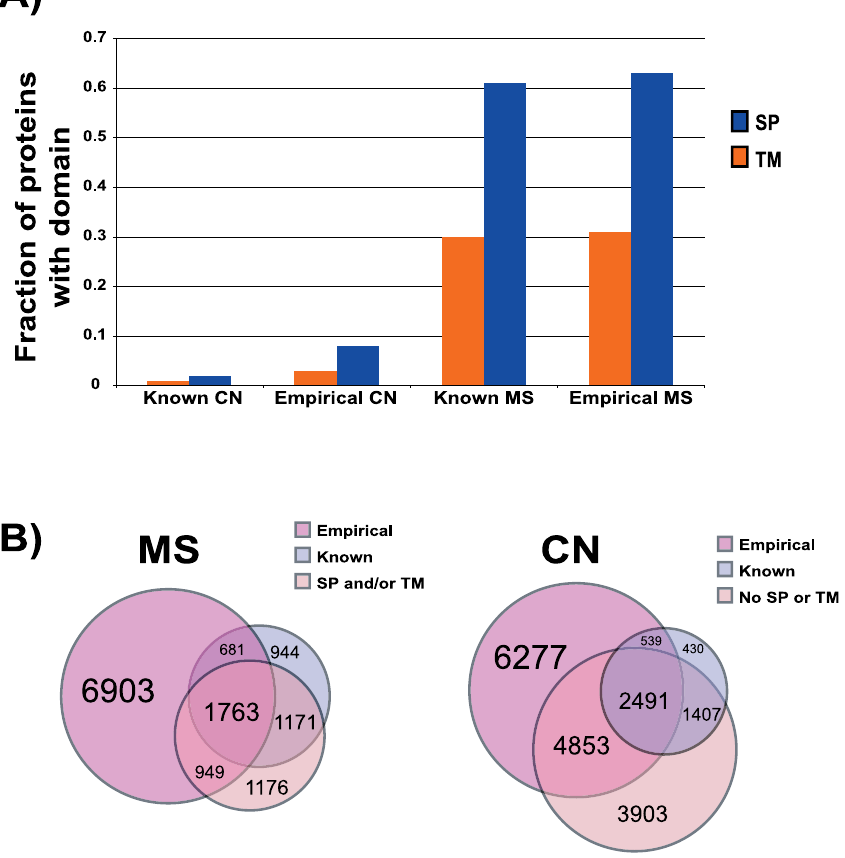
Figure 3. Comparison of Empirical Classifications of MS and CN Genes with In Silico Prediction Methods (A) We were able to retrieve curated, NP protein accessions for 5,504 of the well-measured UniGene clusters on our arrays. The prediction algorithms used were SignalP (HMM/Smean score method) [33] for SPs and TMHMM (first60 score cutoff greater than 10) [34] for TM domains. In order to calculate the fraction of proteins within a category that contained a given motif, the overlap between that category and the genes with protein sequences was used. (B) Venn diagrams showing the overlap between the empirically determined cDNA clones, clones with in silico predictions, and clones encoding proteins with known subcellular localization. For this analysis, we were able to retrieve representative protein accessions for 10,006 cDNA clones from UniGene and applied the prediction algorithms as in (A). DOI: